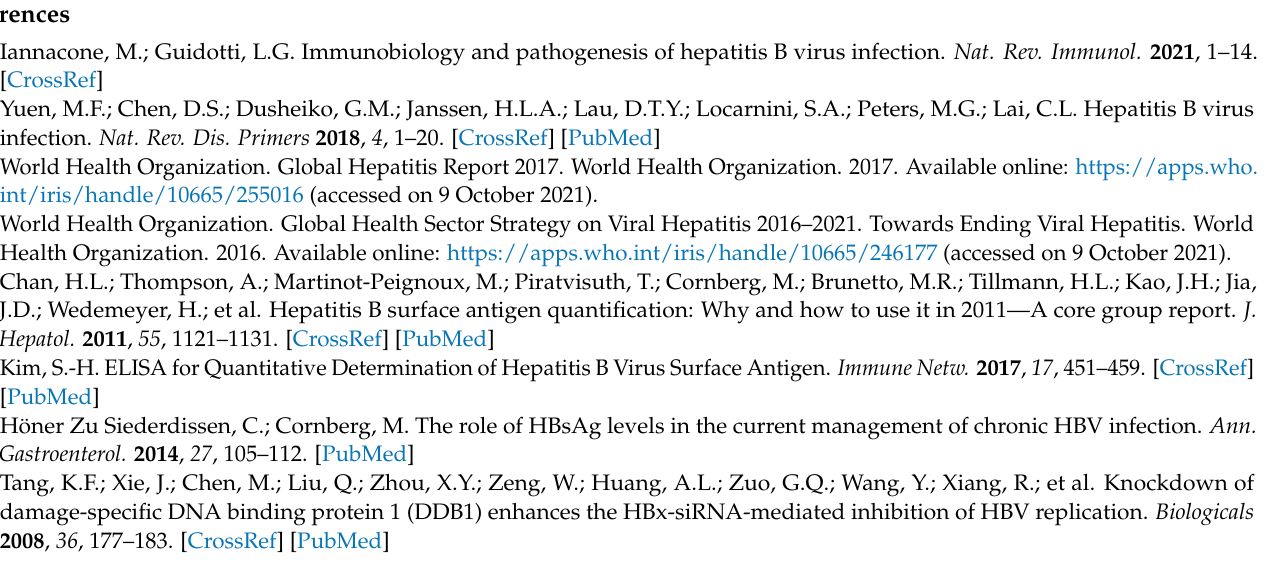
Figure S2: The electrical properties of three baselines of one functionalized device and nine nude devices, Figure S3: The extraction of threshold voltage of pSiNWFET, Figure S4: The top-view SEM image of the device, Figure S5: The SEM images of the HBsAb immobilization